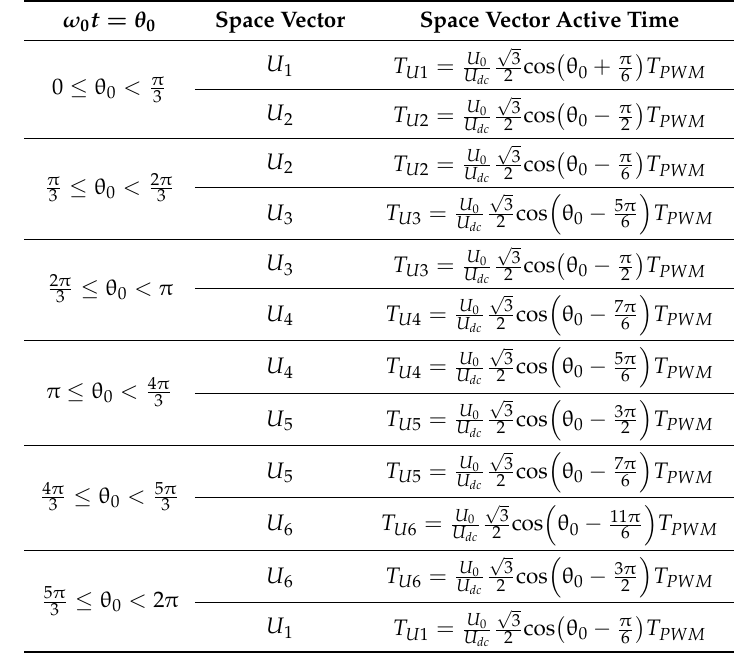
Table 1. Space vector and active time in the